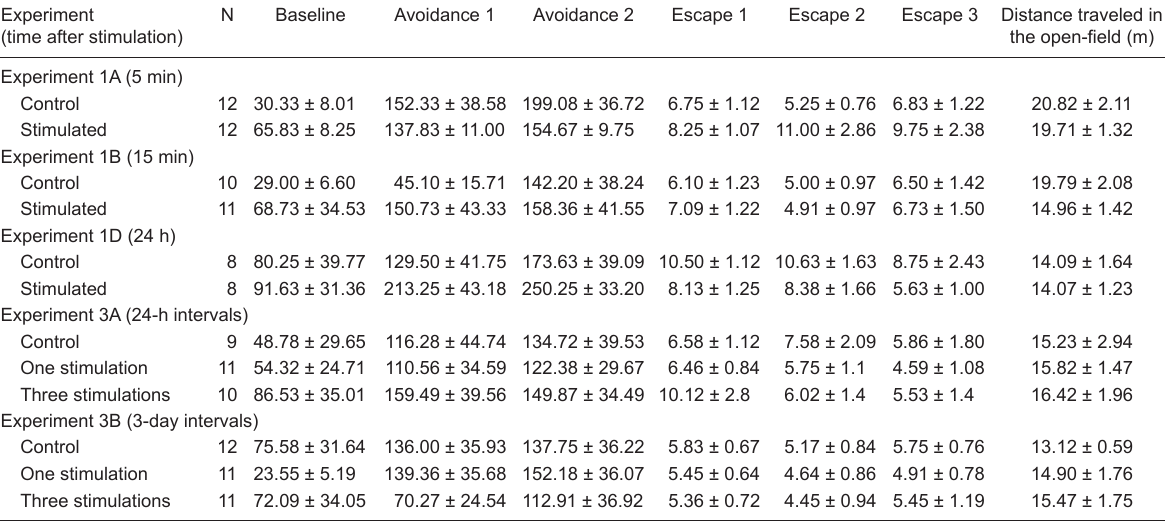
Table 1. Effect of the dorsal periaqueductal gray matter electrical stimulation on the behaviors measured in the elevated T-maze and open-field. Experiment (time after